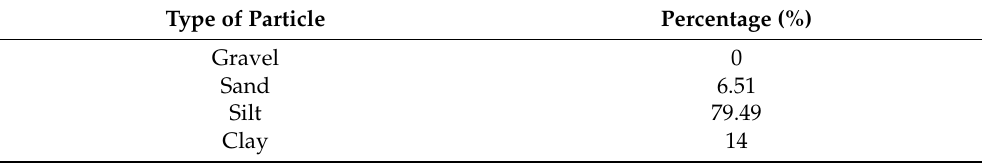
Table 1. Geological composition of soil.